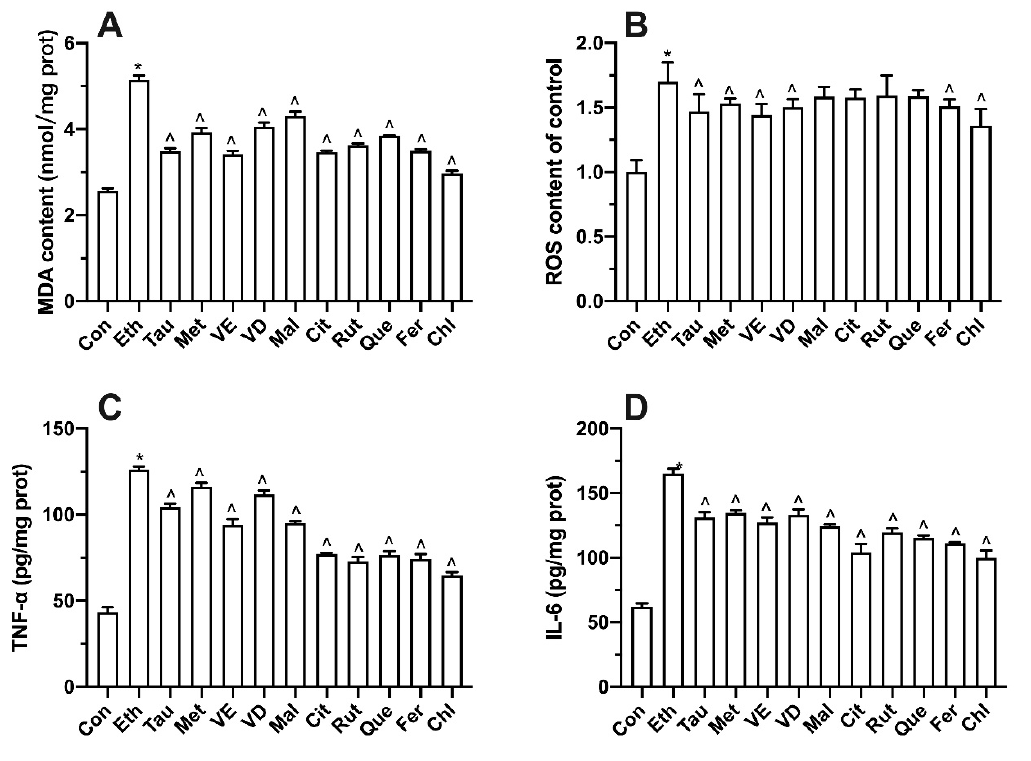
Figure 8. Effect of bioactive compounds on malondialdehyde ( A ), reactive oxygen species ( B ), TNF- α ( C ), and IL-6 ( D ) in L02 cell lines treated for 100 mM ethanol for 12 h. Values represent means ± SD (n ≥ 6). * p < 0.05 compared with the control group, ^ p < 0.05 compared with the 100 mM ethanol group. Tau, taurine; Met, methionine; VE, vitamin E; VD, vitamin D; Mal, malic acid; Cit, citric acid; Rut, rutin; Que, quercetin; Fer, ferulic acid; Chl, chlorogenic acid.